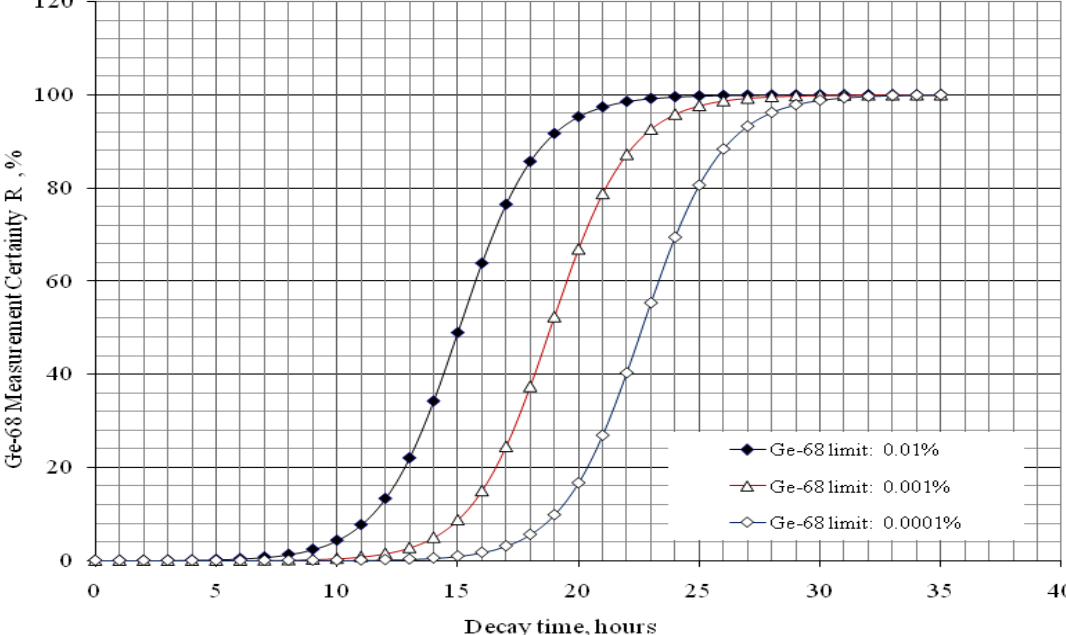
Figure 14. Certainty parameter R versus decay time t of the 68 Ge impure radionuclide in 68 Ga radioisotope product at different required radio-nuclidic impurity limits L . Poisson distribution 95% confidence interval, 1.96 , C C ± with error < 8.77% for count